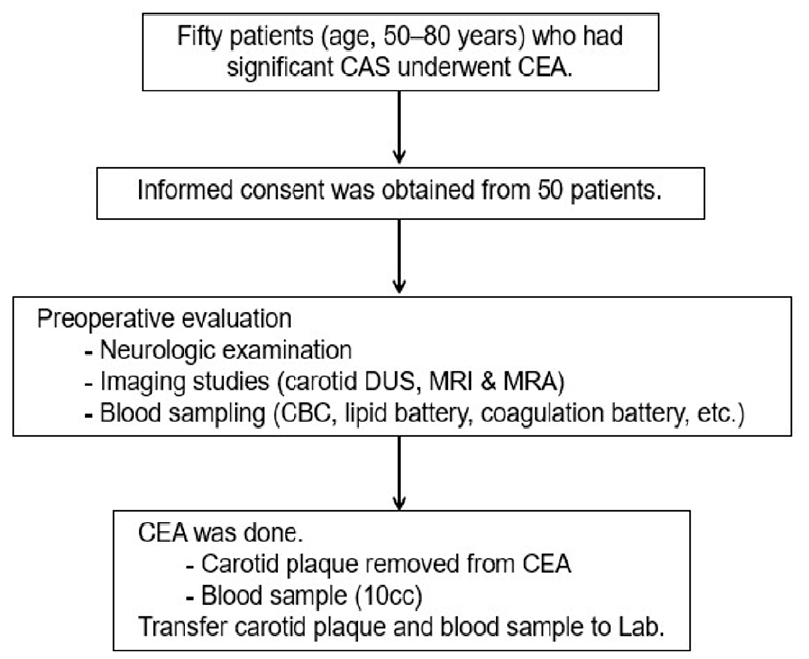
Figure 1. Diagram of the study design. CAS, carotid artery stenosis; CEA, carotid endarterectomy; CBC, complete blood count; DUS, Doppler ultrasound; MRA, magnetic resonance angiography, MRI, magnetic resonance